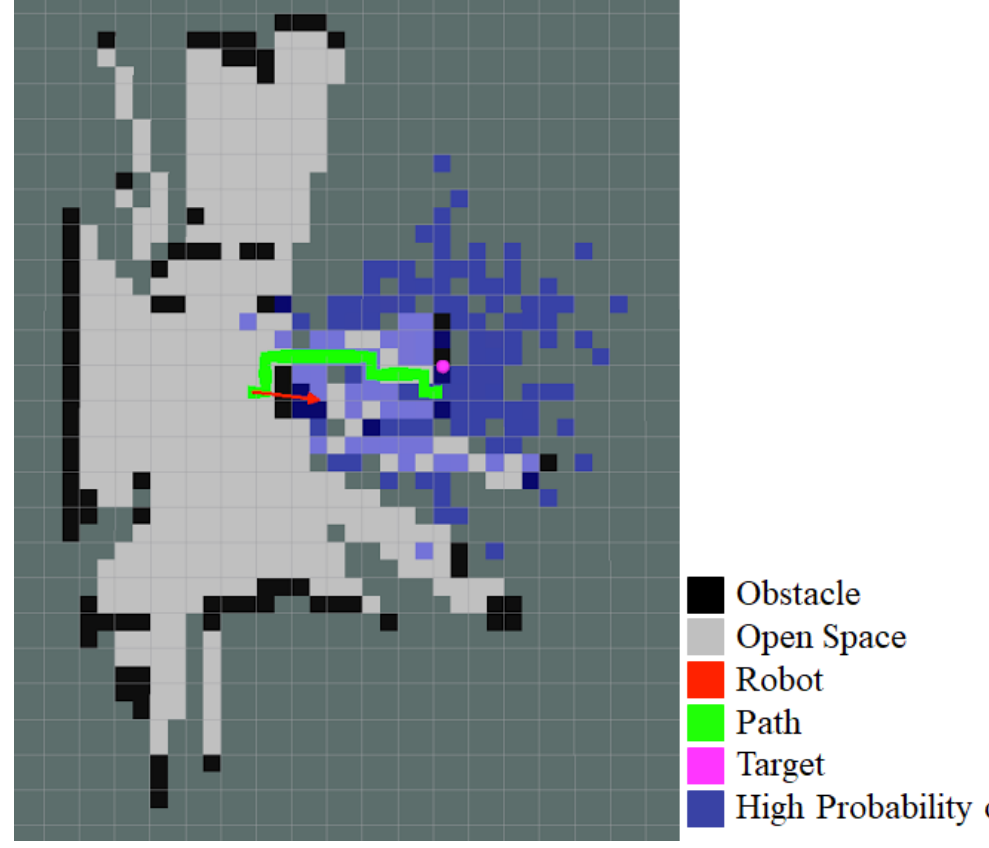
Figure 12. Visualisation of the map, particle filter, and path.